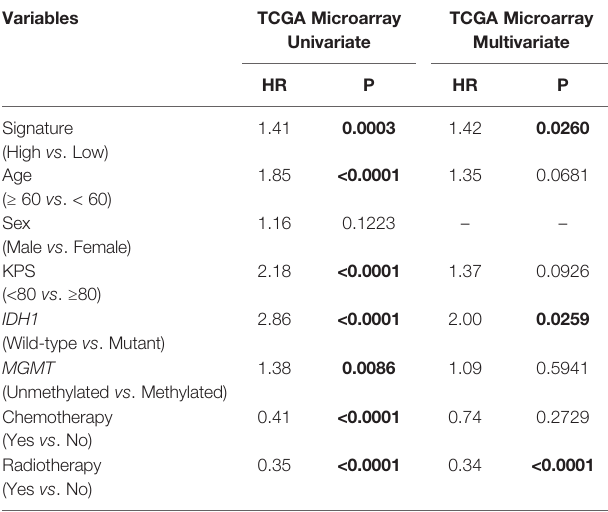
TABLE 1 | COX regression analysis of the risk score based on the TF signature and other covariates in